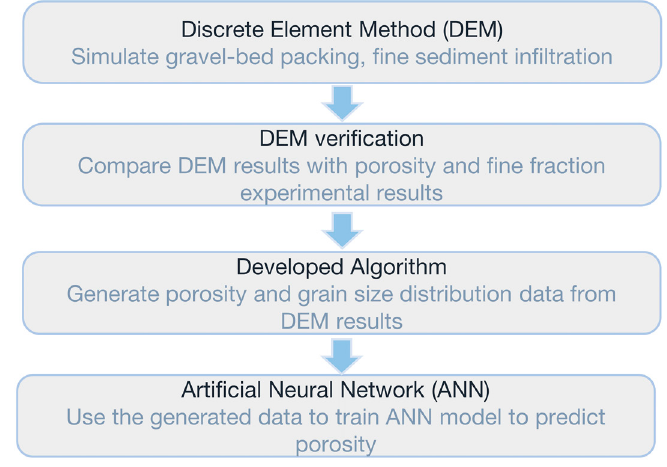
Figure 1. Schematization of porosity estimation using DEM and ANN.